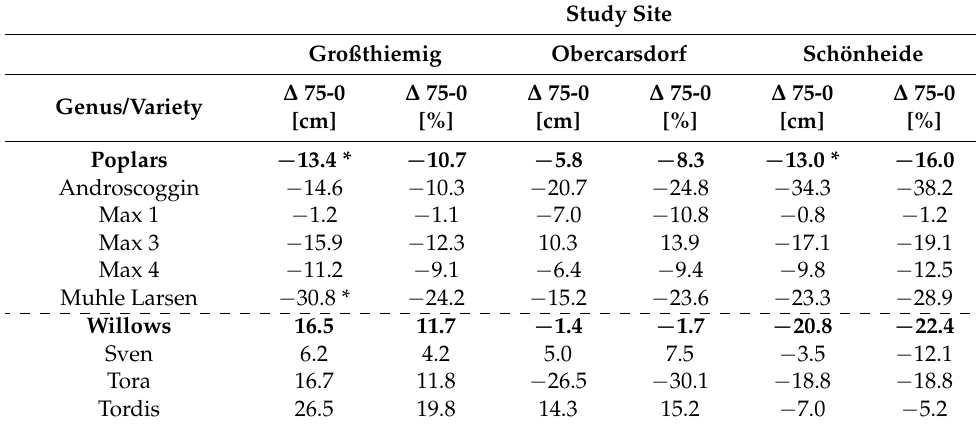
Table 1. Height differences of 75% defoliated and undefoliated plants ( ∆ 75-0) in December 2007 after the first defoliation treatment (bold values indicate mean values of all varieties of a tree genus, * statistically significant difference according to t